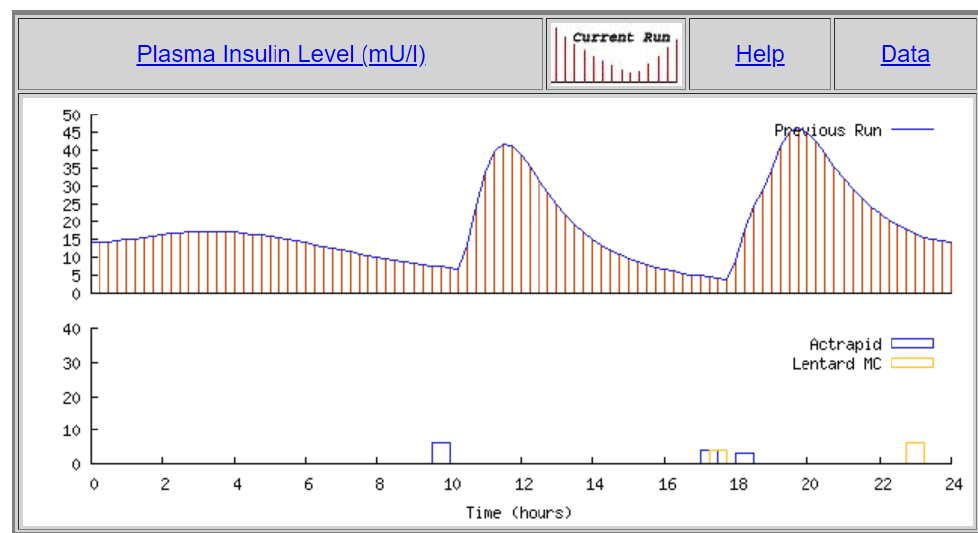
Figure 1. Plasma insulin for one simulation (plot generated by the AIDA2 simulator).